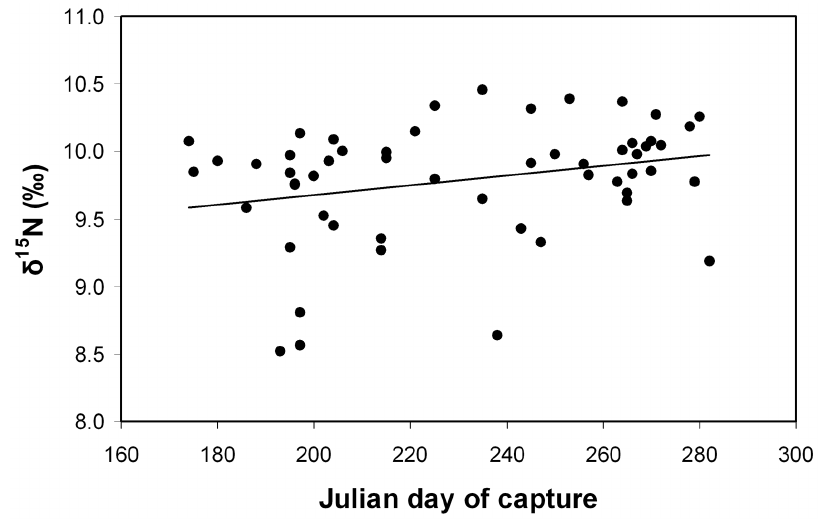
Figure 1. Relationship between the d 15 N value in muscle and the Julian day in which the individual was sampled (r 2 =0.0729, p , 0.05).